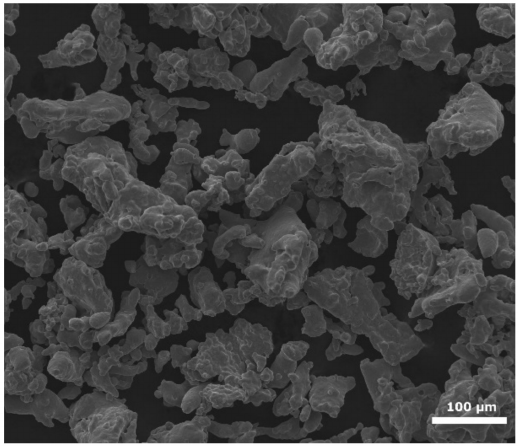
Figure 4. AISI H13 powder particles employed as raw material for manufacturing the